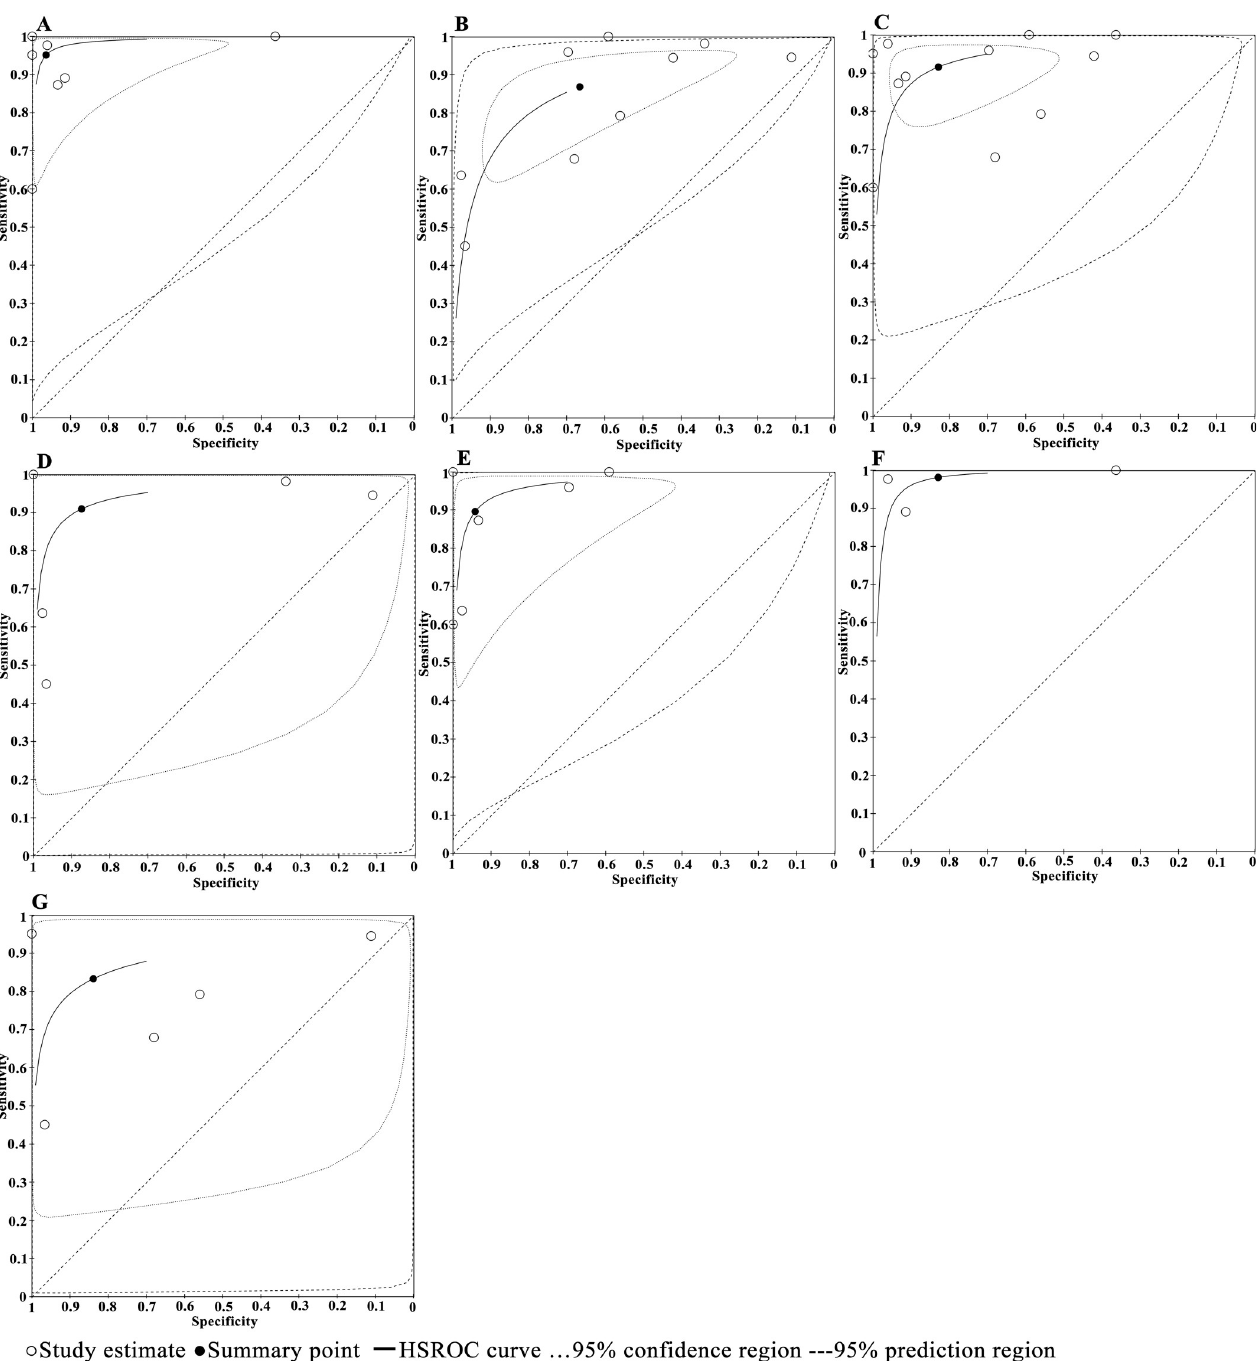
Fig 6. HSROC curves of subgroup analyses based on research design (A and B), biological samples (C and D) and PCR method (E-G). A) case-control design, B) cross-sectional design, C) based on blood samples, D) based on stool samples, E) conventional PCR, F) nested PCR, G) real-time PCR.